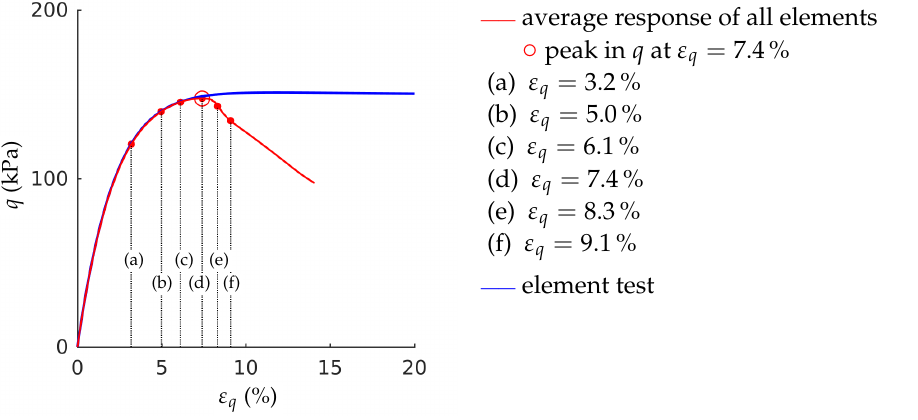
Figure 11. OCR = 3: The global deviatoric strain ε q marked with ( a – f ) corresponds to Figure